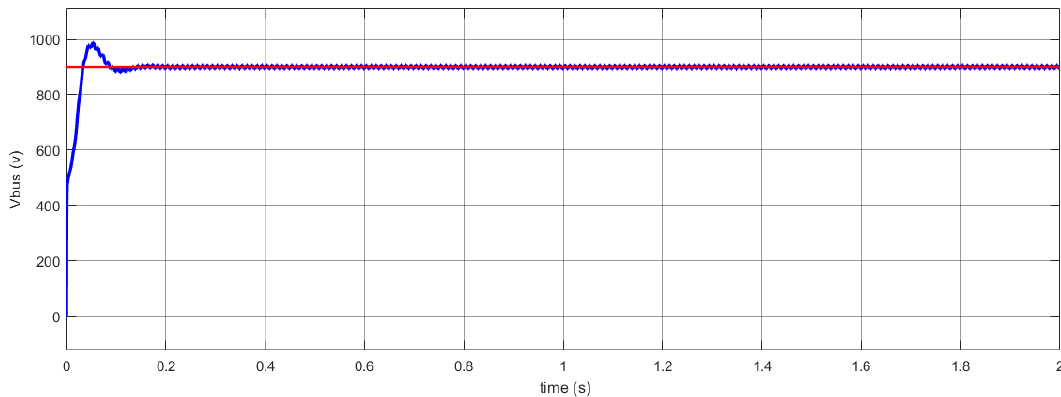
Figure 9. DC Bus voltage.